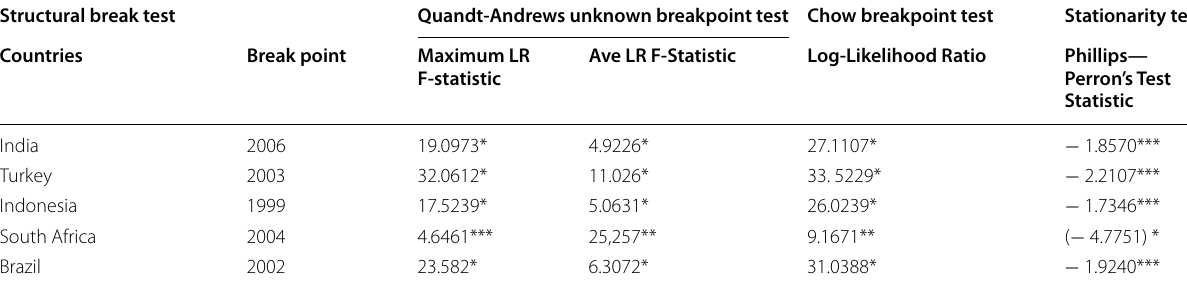
Table 2 Unit root test statistics and structural break Structural break test